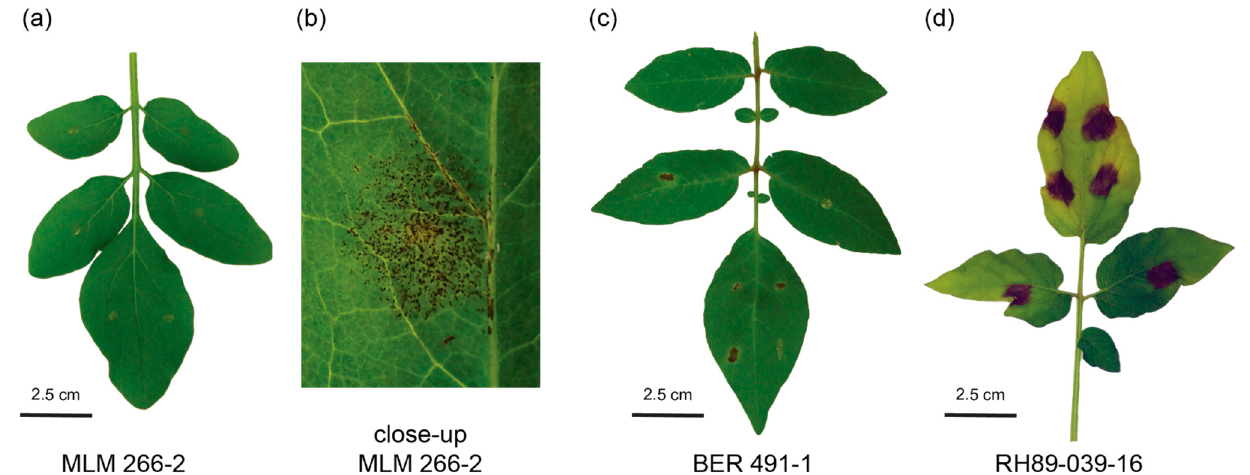
Figure 2. Disease symptoms on different Solanum genotypes. Pictures were taken from representative leaves 5 days post inoculation of S. commersonii subsp. malmeanum (MLM) 226-2 ( a ) and in close-up ( b ), S. berthaultii (BER) 491-1 ( c ) and S. tuberosum RH89-039-16 ( d ).